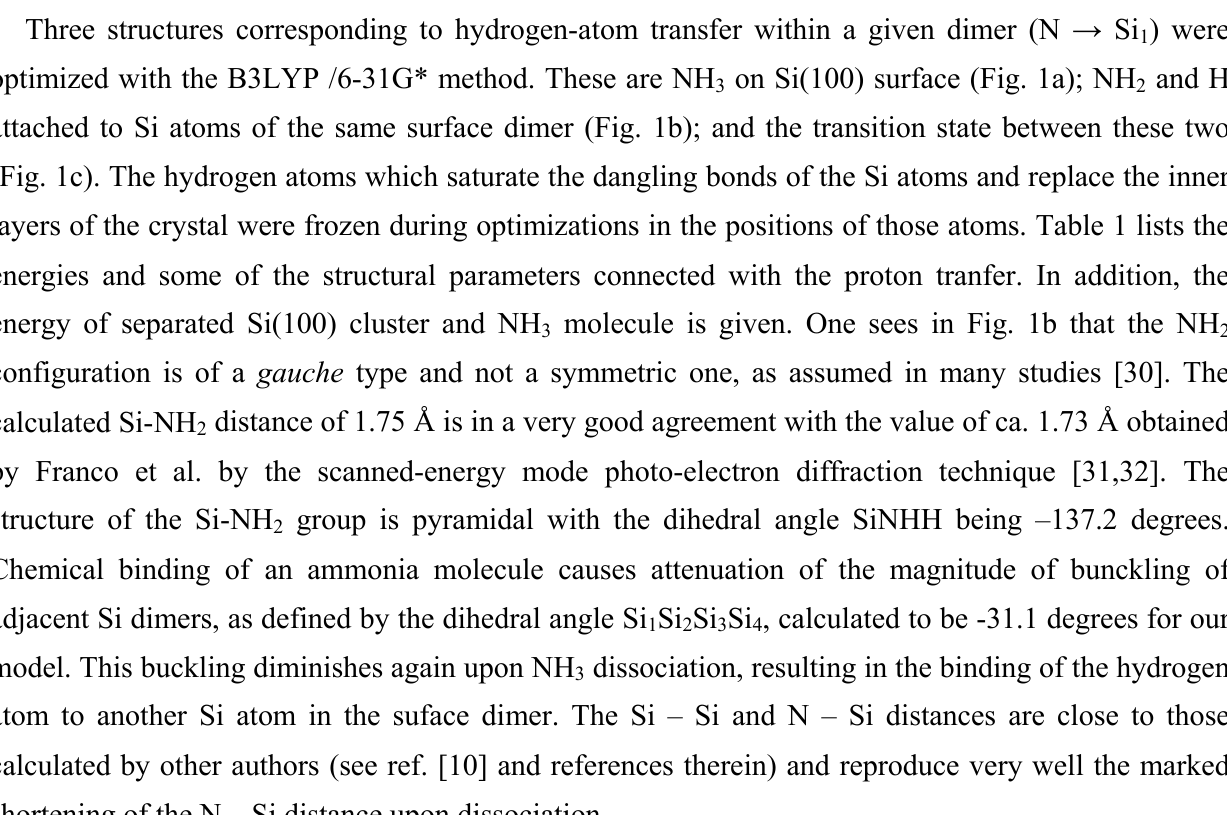
, b) dissociated NH with the H atom on the other 3 3